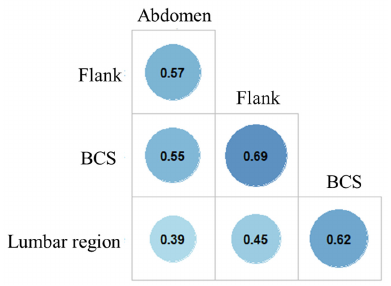
Figure 2. Correlation between body condition score and subcutaneous fat thickness assessed at three different locations ( n = 88 Labradors). Note: BCS: body condition score; Pearson’s correlation coefficient is given for bivariate correlation between all pairs ( p < 0.001 for all).